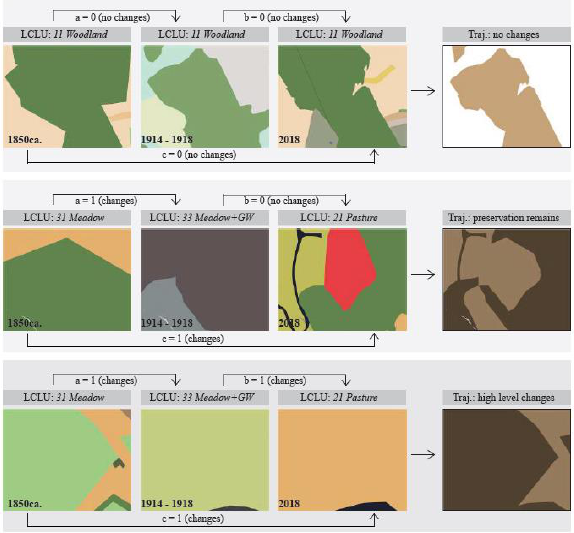
Figure 11 . Mapping attitudes to change: operative